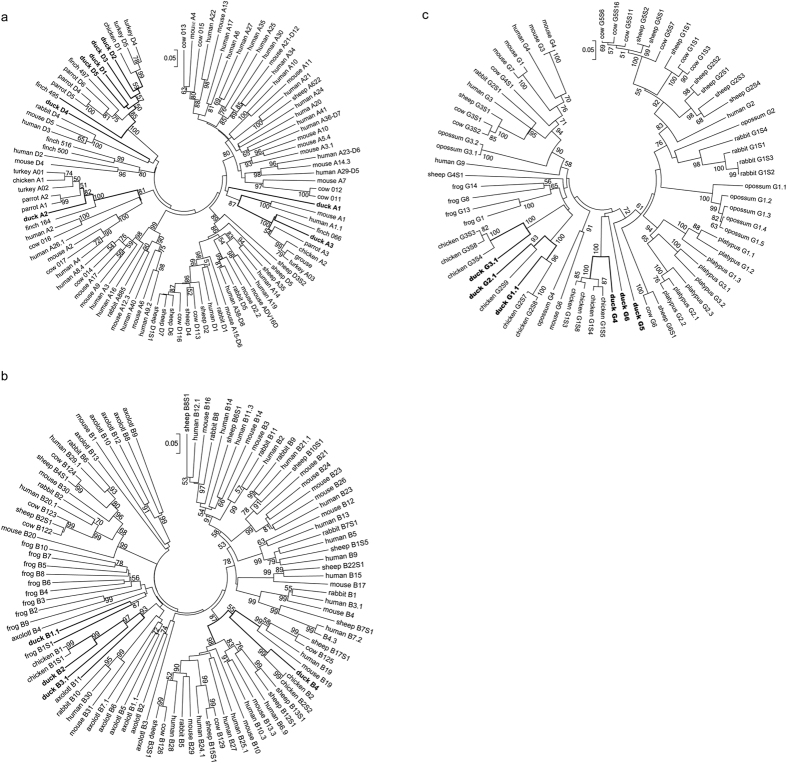
Phylogenetic analyses of the TCR V gene segments from representative mammalian, avian and amphibian species, Vα and Vδ (a), Vβ (b) and Vγ (c). The unrooted trees were constructed using the neighbour-joining method with nucleotide sequences corresponding to FR1 through FR3. Duck V gene segments are indicated in bold. Numbers next to the branches show the percentages of the nodes in 1,000 bootstrap replicates.